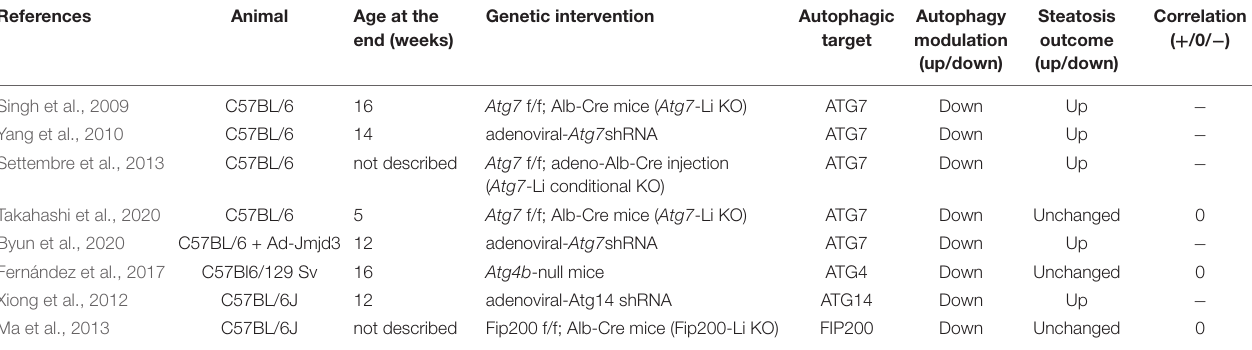
TABLE 7 | Autophagy protein genetic interventions plus chow or LFD diets. Animal Age at the Genetic intervention Autophagic end (weeks)